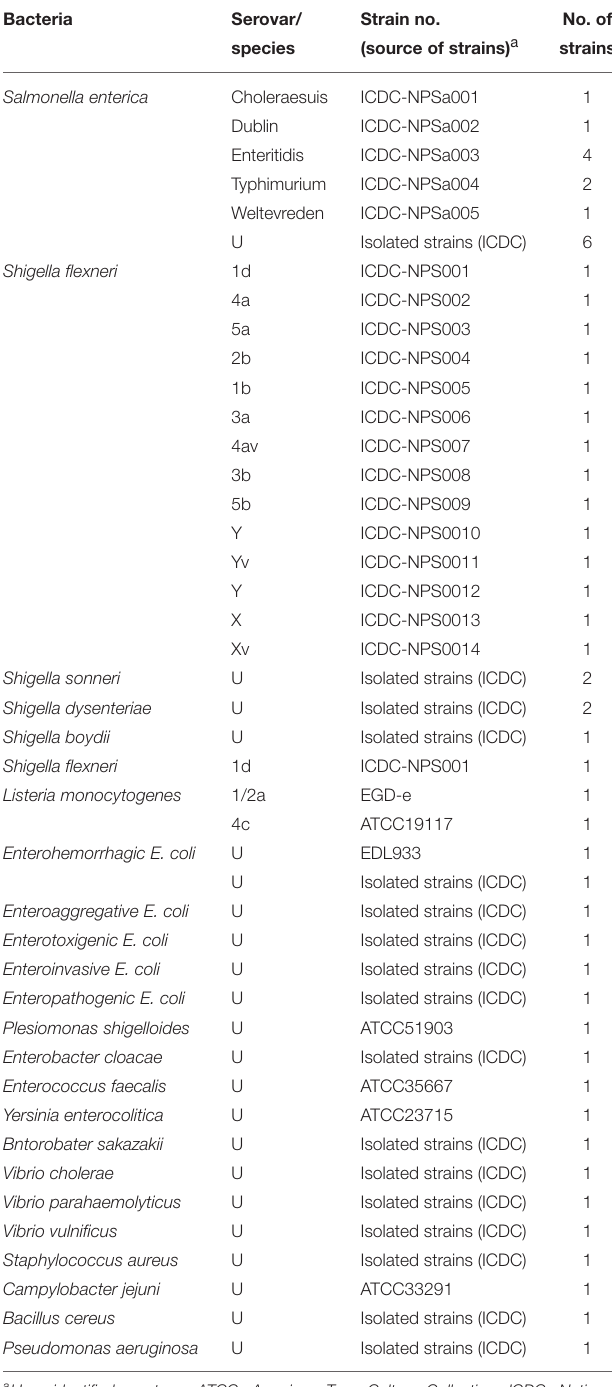
TABLE 2 | Bacterial strains used in this study. Bacteria Serovar/ Strain